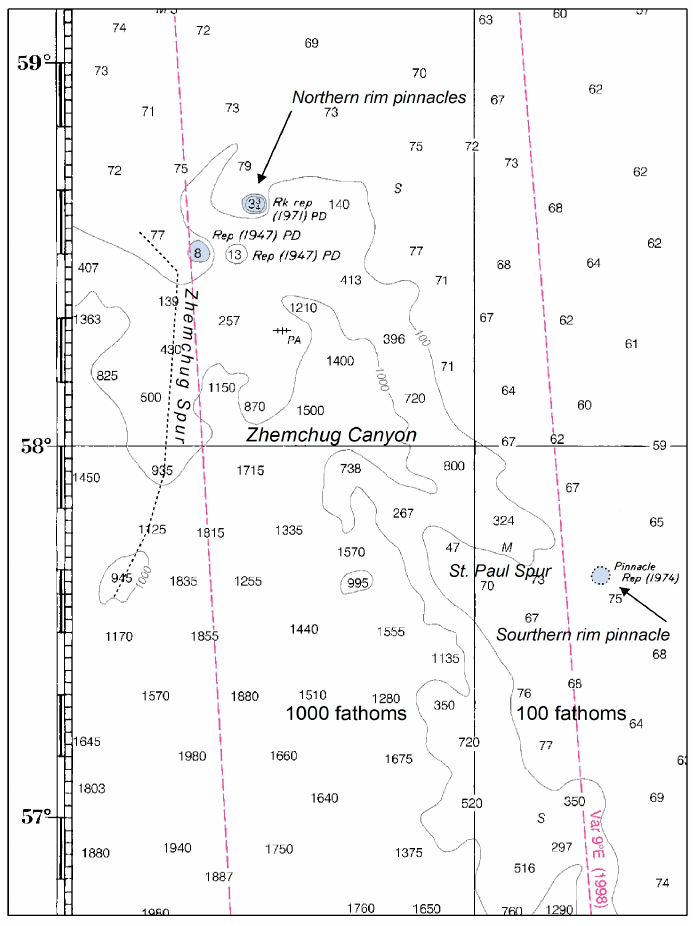
Figure 3. Detail of NOS navigational chart 16006 (Edition 37, 2015, Scale 1:1,534,076), showing reported pinnacles in the Zhemchug Canyon area.